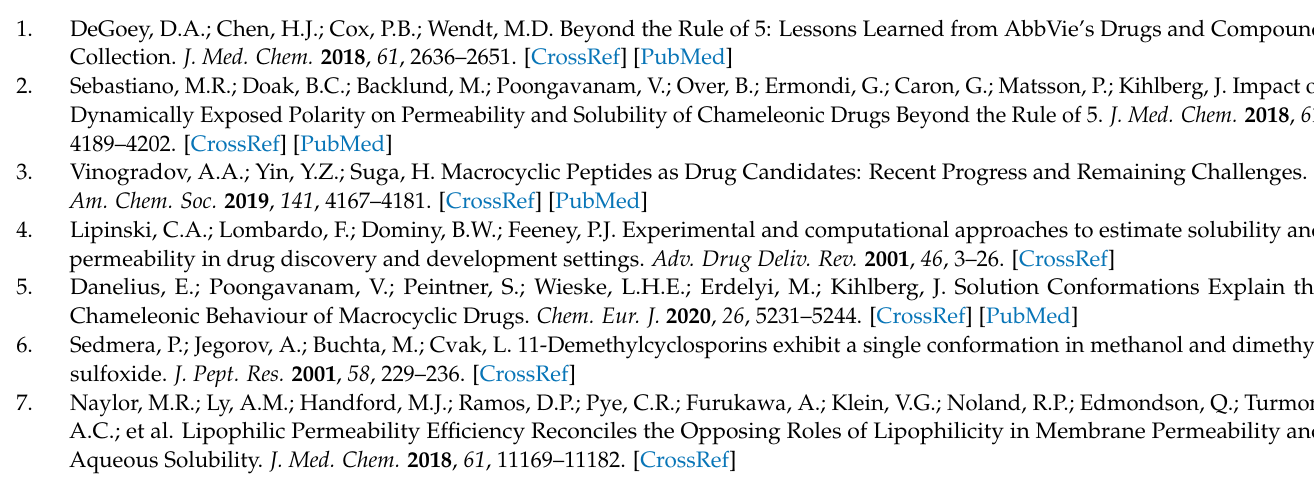
energy of the neutral (unprotonated) intermediate; Figure S5: Folding energy of the monoprotonated (terminal) intermediate; Figure S6: Folding energy of the monoprotonated (interior) intermediate; Figure S7: Folding energy of the diprotonated intermediate; Figure S8: Folding energy vs. number of protons; Figure S9: The 400 MHz 1H NMR spectrum of 1 in DMSO- d6 ; Figure S10: The 100 MHz 13C{1H} NMR spectrum of 1 in DMSO- d6 ; Figure S11: The 400 MHz 1H NMR spectrum of 2 in DMSO- d6 ; Figure S12: The 100 MHz 13C{1H} NMR spectrum of 2 in DMSO- d6 ; Figure S13: The 400 MHz 1H NMR spectrum of 3 in DMSO- d6 ; Figure S14: The 100 MHz 13C{1H} NMR spectrum of 3 in DMSO- d6 ; Figure S15: The 400 MHz 1H NMR spectrum of GEA in DMSO- d6 ; Figure S16: The 100 MHz 13C{1H} NMR spectrum of GEA in DMSO- d6 ; Figure S17: The 400 MHz COSY of GEA in DMSO- d6 ; Figure S18: The 400 MHz 1H NMR spectrum of VEA in DMSO- d6 ; Figure S19: The 100 MHz 13C{1H} NMR spectrum of VEA in DMSO- d6 ; Figure S20: The 400 MHz COSY of VEA in DMSO- d6 ; Figure S21: The 400 MHz 1H NMR spectrum of IEA in DMSO- d6 ; Figure S22: The 100 MHz 13C{1H} NMR spectrum of IEA in DMSO- d6 ; Figure S23: The 400 MHz COSY of IEA in DMSO- d6 ; Figure S24: The 400 MHz 1H NMR spectrum of 4 in DMSO- d6 ; Figure S25: The 100 MHz 13C{1H} NMR spectrum of 4 in DMSO- d6 ; Figure S26: The 400 MHz 1H NMR of G-G in DMSO- d6 ; Figure S27: The 400 MHz 1H NMR of V-V in DMSO- d6 ; Figure S28. The 400 MHz 1H NMR of I-I in DMSO- d6